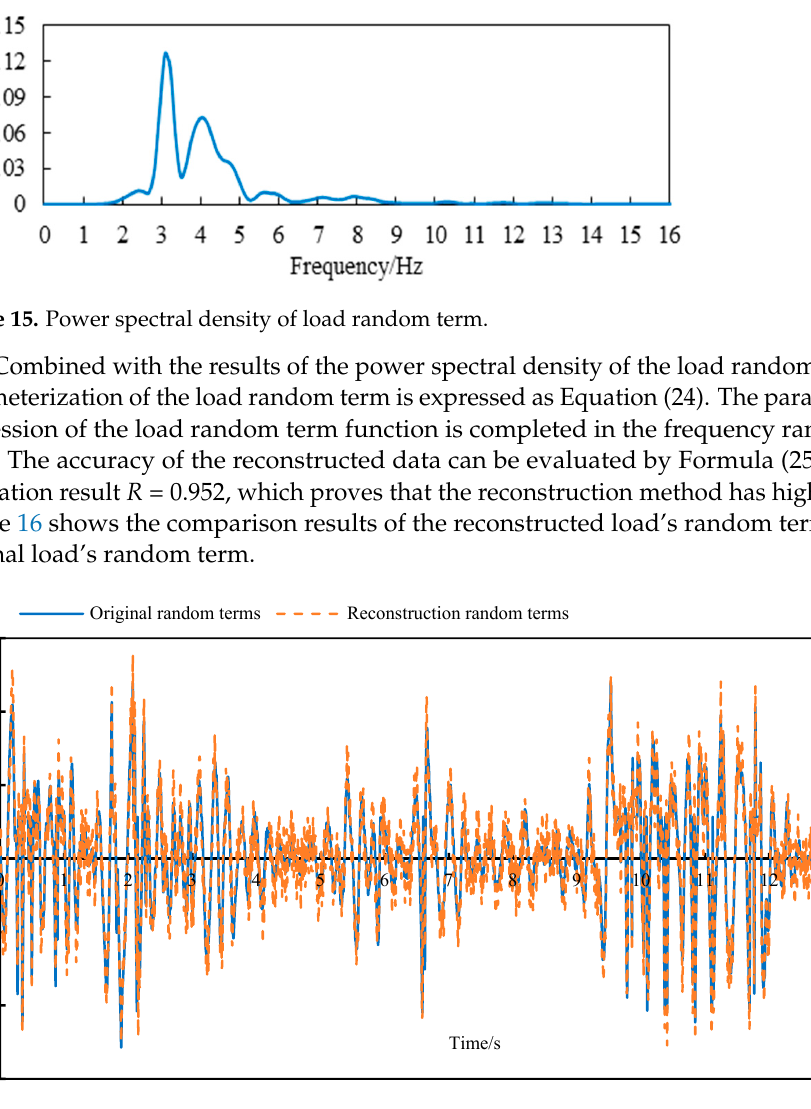
Figure 16. The comparison result between the reconstructed and original load random term.